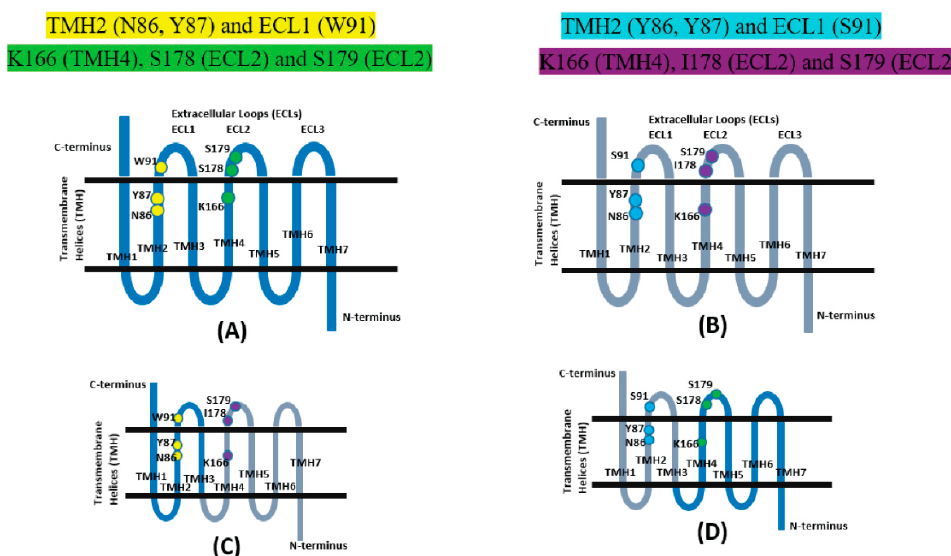
Figure 8. Schematic structure of GPCRs with seven transmembrane helices (TMH) and three extracellular loops (ECLs). Major residues involved in the interaction with HA are highlighted. ( A ) GPR109A, Major residues involved in interaction with HA are highlighted in yellow and green. ( B ) GPR109B, Major residues involved in interaction are highlighted in cyan and purple. ( C ) Chimera 3A4B (first three helices from GPR109A (in blue color) and remaining four from GPR109B (in gray color)). ( D ) Chimera 3B4A (first three helices from GPR109B (in gray color) and remaining four from GPR109A (in blue color)).